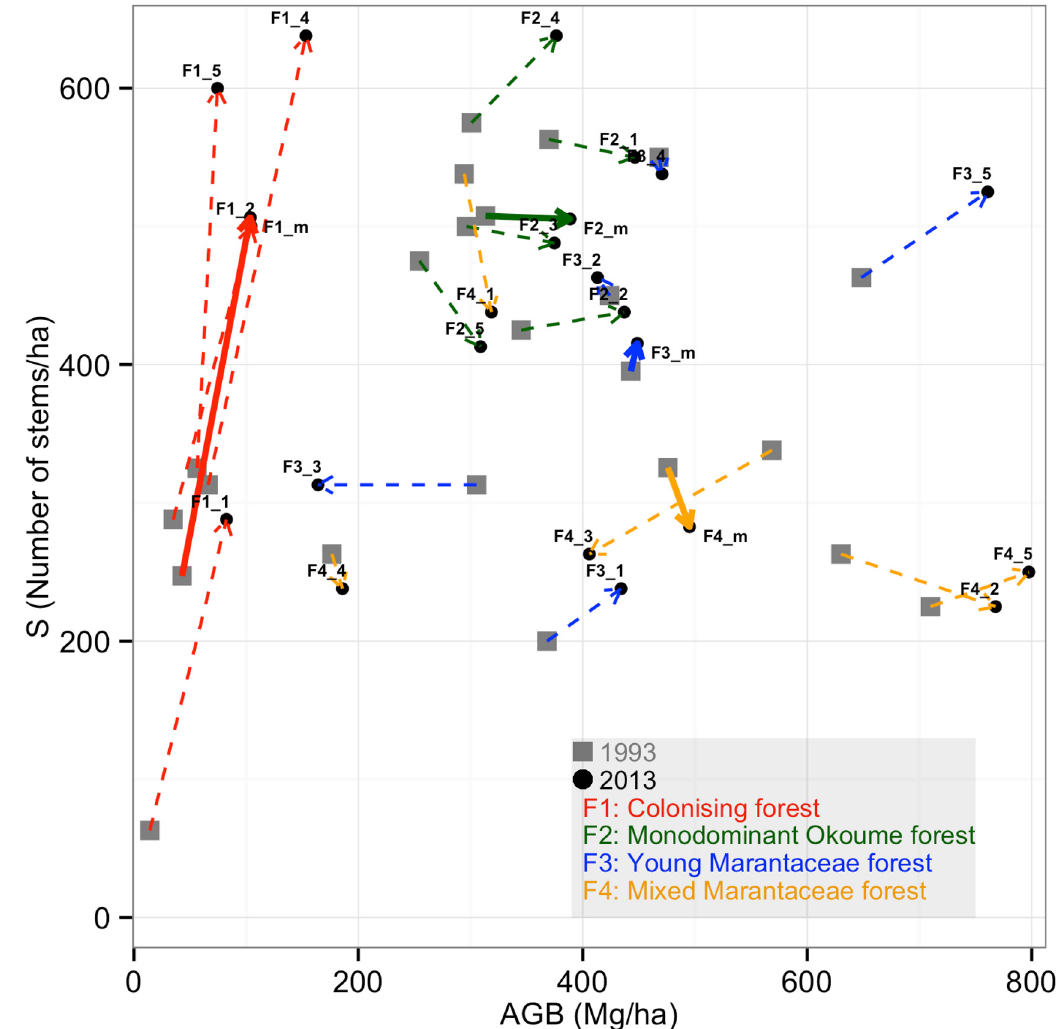
Fig 4. Changes of plots over time with regard to AGB and SD for each single plot (dotted line), and the mean per forest type (continuous